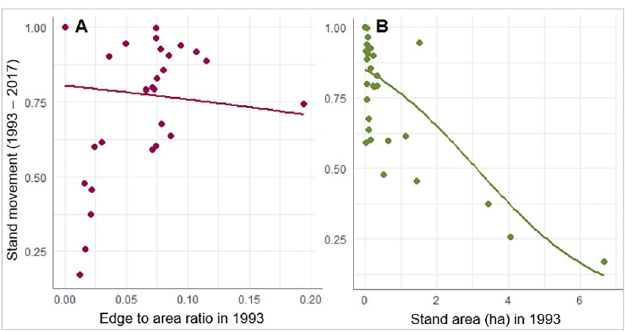
Fig 9. Stand movement from 1993 to 2017: A) the effect of edge to area ratio in 1993 and B) the effect of stand area in 1993. Stand movement on the y-axis represents the proportion of a whole stand area that has moved (1 = max.). The curve superimposed over stand data represents expected values across range of predictor variable with the other variable held constant at its mean value.